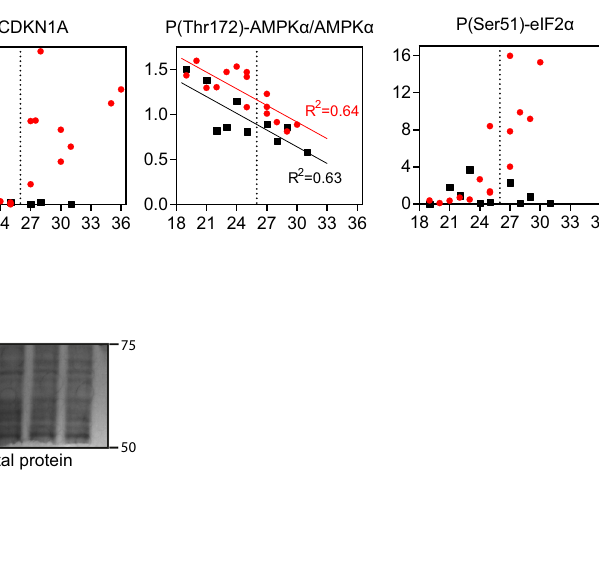
Statistics:one-wayANOVAfollowedbytheselectedpairwisecomparisons(Welch ’ s t -statistics). The error bars represent 95%-CI of mean. All data points derive from independent mice. Source data are provided as a Source Data fi